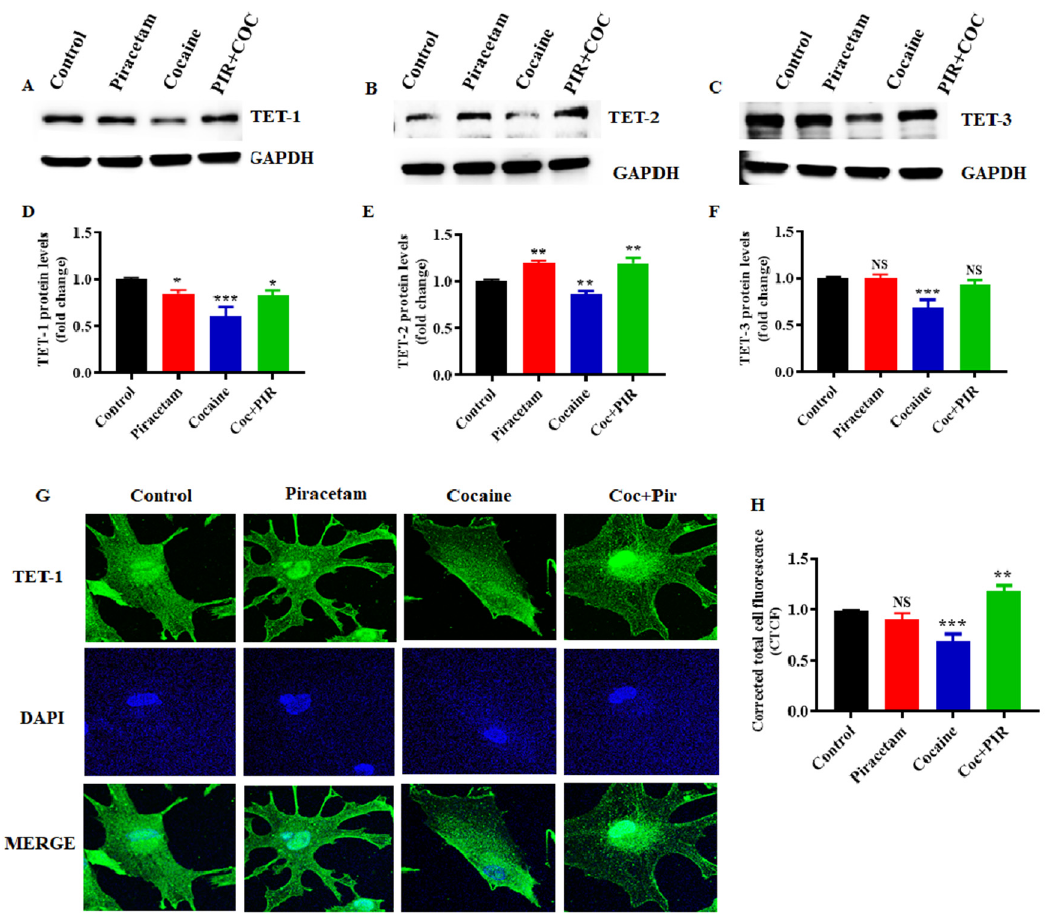
Figure 6. Piracetam reversed the impact of cocaine on TET protein expression. Human primary astrocytes (2.5 × 10 6 cells / mL) were exposed to cocaine (1 µ M) and / or piracetam (10 µ M) for 24 h. Total cell lysates were resolved by SDS-PAGE and analyzed by western blots showing the expression of ( A ) TET-1, ( B ) TET-2 and ( C ) TET-3. ( D – F ) Densitometric analysis of the level of each protein relative to the level of GAPDH as a loading control (fold change relative to the control). The data are expressed as the mean ± SD of three independent experiments. *** p < 0.001, ** p < 0.01, * p < 0.05, NS—nonsignificant. ( G ) TET-1 (green) immunostaining and cell nuclei, which were stained with DAPI (blue), were observed by confocal microscopy (magnification 100 × scale bar 100 µ m). ( H ) Quantification of TET-1 fluorescence intensity